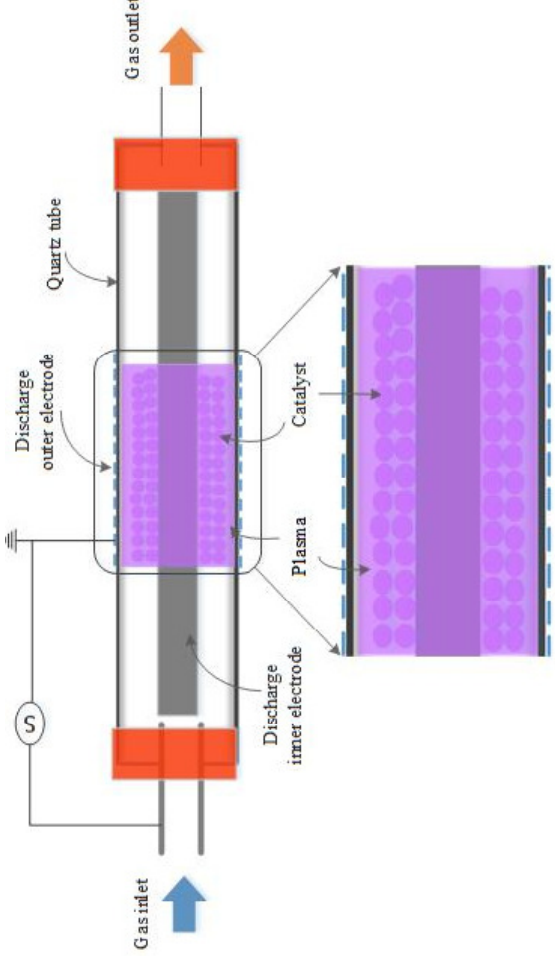
Figure 11. Structure diagram of a coaxial dielectric barrier discharge non-thermal plasma reactor.